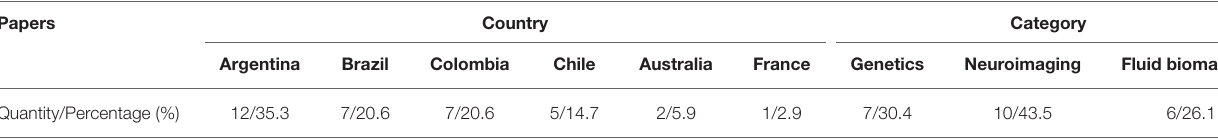
TABLE 2 | Quantity distribution of papers.